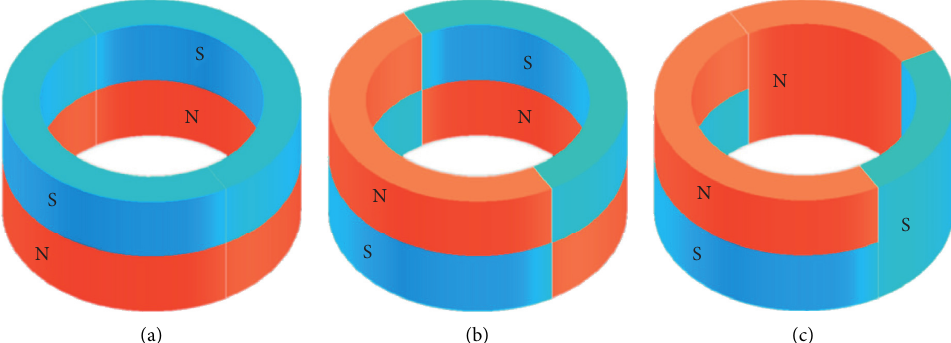
Figure 7: Magnetic circuit design scheme when the valve seat consists of two identical shape tile magnets. (a) Scheme 1. (b) Scheme 2. (c) Scheme 3.